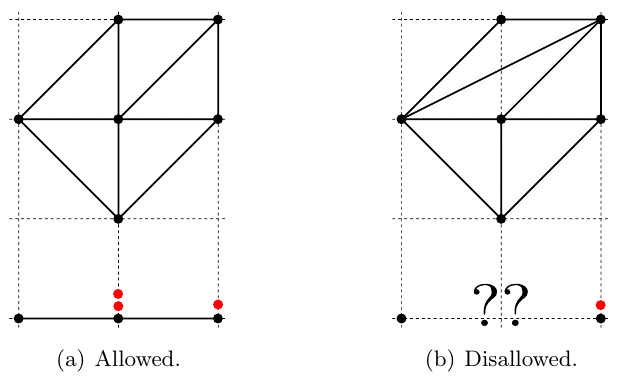
Figure 2 . Left: an example of an allowed vertical reduction of a 2d toric diagram, which gives rise to a resolved A 1 singularity visualized by the 1d toric diagram below. Right: an example of a disallowed vertical reduction, due to the presence of an edge that would collide with either one of the vertices along the vertical direction under such a